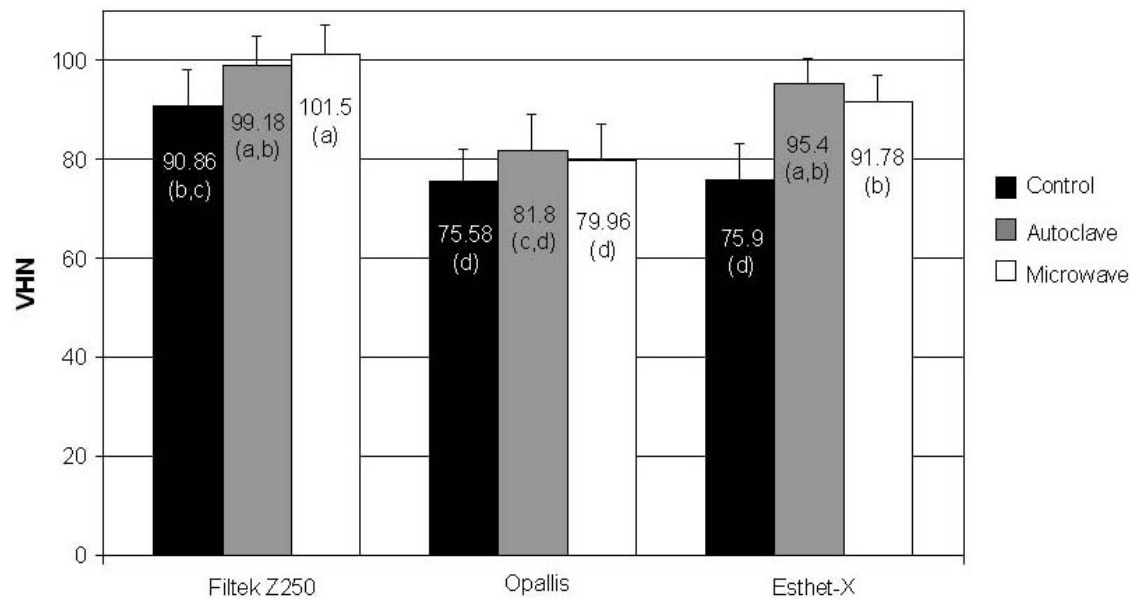
FIGURE 4- Mean and standard deviation of the VHN for each material and post-cure treatment. Different lower case letters show statistically significant